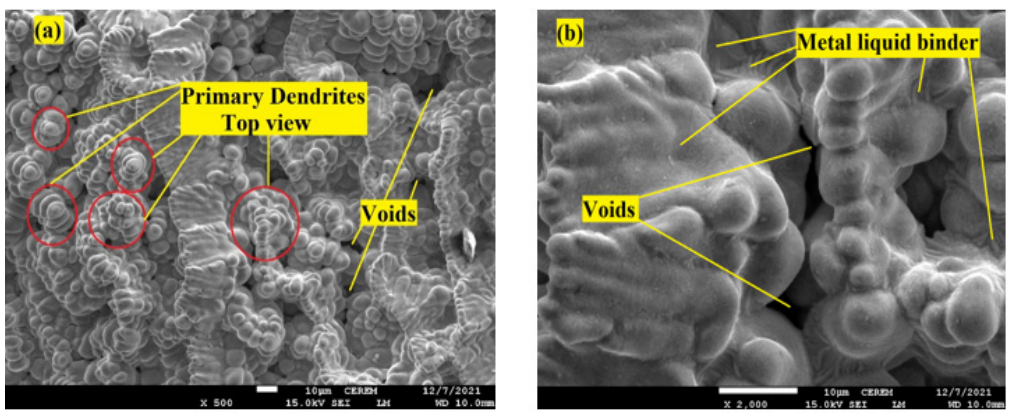
Figure 12. SEM micrograph of solidification hot cracking face in TIG weld coated by pure Nb powder ( × 500).